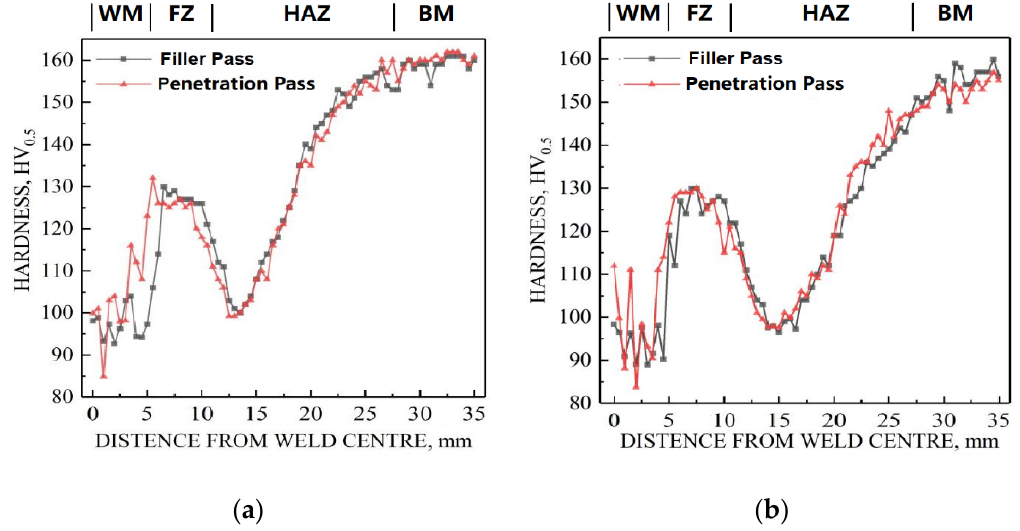
Figure 6. The Vickers hardness distributions from WM to BM: ( a ) sample 1 and ( b ) sample 2.